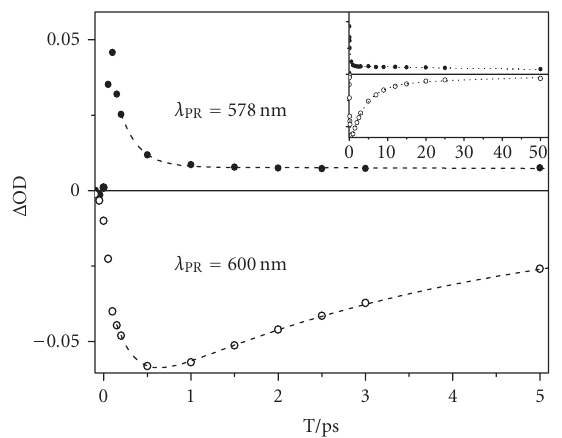
Figure 9: Decay of pump-probe transients during the first 5 picoseconds following excitation measured at probe wavelengths 600 nm (open circles) and 578 nm (filled circles), which corre- sponds to the bleaching/stimulated emission of band 1 and to the photoinduced absorption in the vicinity of band 2, respectively. In the insert, the dynamics on a 50 picoseconds timescale are shown. Dashed lines represent three-exponential fits with time constants 275 femtoseconds, 5.5 picoseconds, and 105 picoseconds (see text for details).